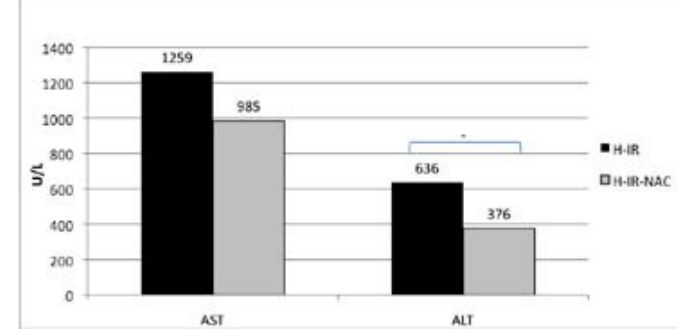
FIGURE 3 - Values of aspartate aminotransferase (AST; p=0.456) and alanine aminotransferase (ALT; *p=0.023) in both